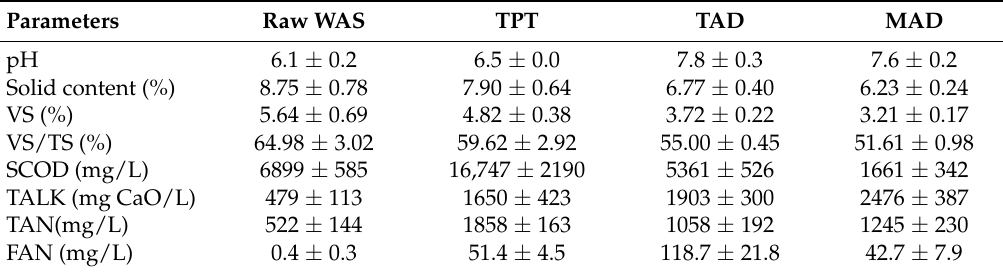
Table 1. Characteristics of